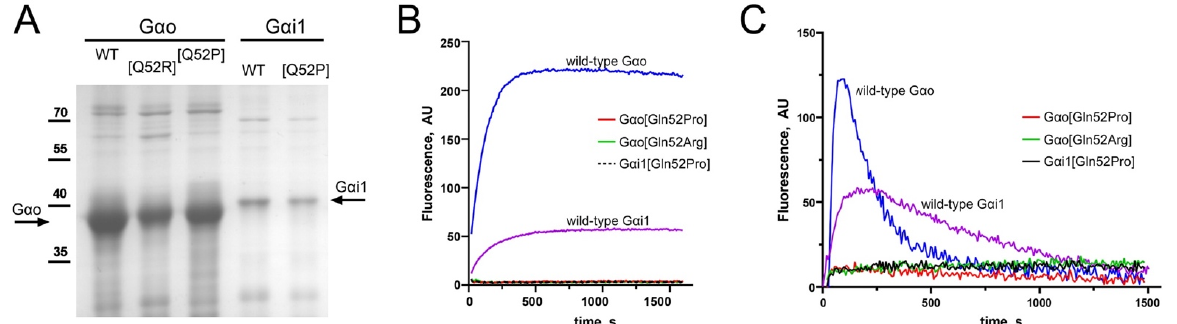
Figure 2. The Gln52 mutant G α o/G α i1 proteins are deficient in GTP binding and hydrolysis. ( A ) Coomassie-stained gel shows protein yields after purification of G α o/G α i1 recombinant proteins (arrows); expression and purification were performed in parallel. A decrease in the yields of mutant proteins (Q52P and Q52R) as compared to the wild-type (WT) versions can be seen as indicative of the overall lesser stability of the mutants. ( B , C ) Time course of binding of 1 µM BODIPY-GTP γ S ( B ) or BODIPY-GTP ( C ) and 1 µM wild-type or mutant G α o/G α i1 proteins. While the wild-type proteins display the characteristic binding ( B ) and binding-hydrolysis ( C ) curves, the three mutant versions are incompetent in binding and hydrolysis of GTP). The gel ( A ) and the GTP binding ( B ) and binding-hydrolysis ( C ) experiments are representatives of three independent experiments.